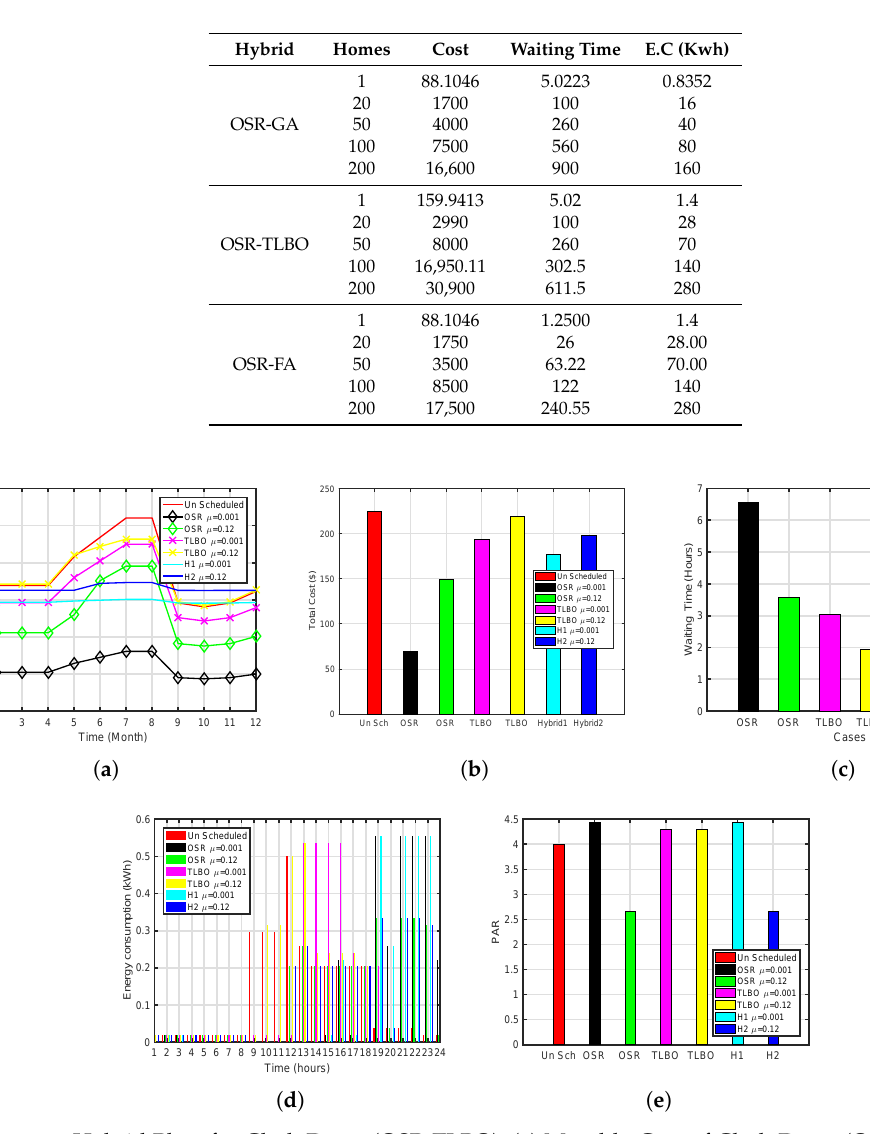
Figure 7. Hybrid Plots for Cloth Dryer (OSR-TLBO). ( a ) Monthly Cost of Cloth Dryer (OSR-TLBO), ( b ) Total Cost of Cloth Dryer (OSR-TLBO), ( c ) Waiting Time of Cloth Dryer (OSR-TLBO), ( d ) Energy Consumption of Cloth Dryer (OSR-TLBO), ( e ) PAR of Cloth Dryer